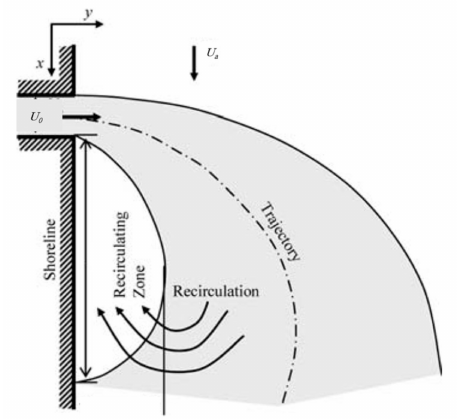
Figure 13. Plan view of recirculating zone formation in a JICF